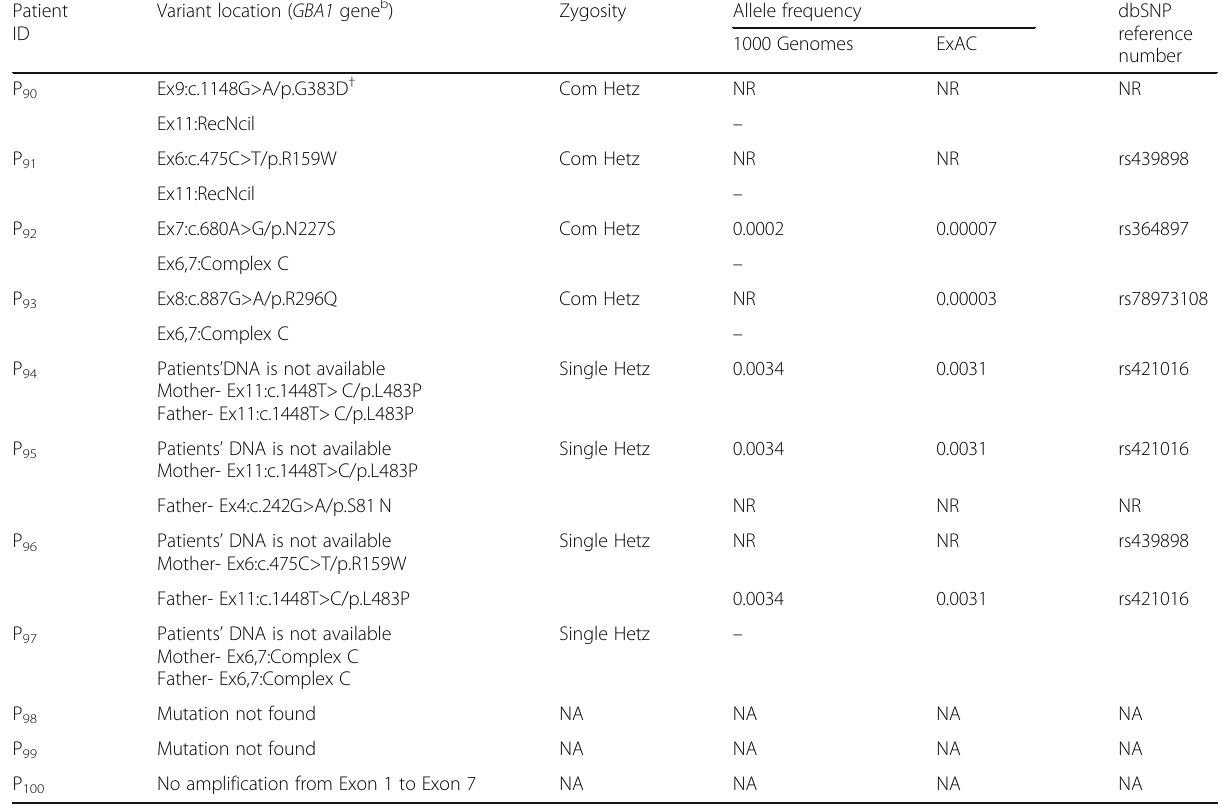
Table 2 Molecular analysis of the patients with Gaucher disease (Continued) Patient Variant location ( GBA1 gene b ID